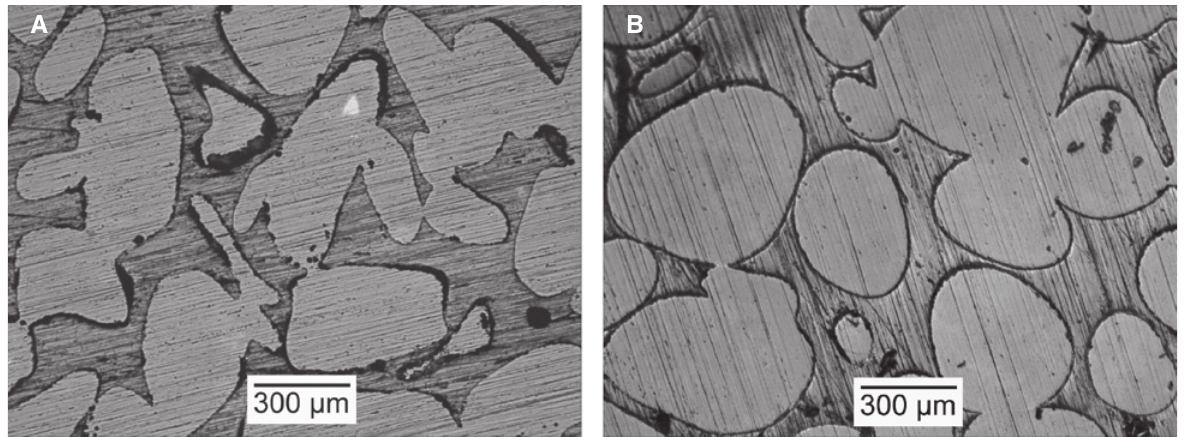
.All samples were sintered at 750 ° C for 30 2